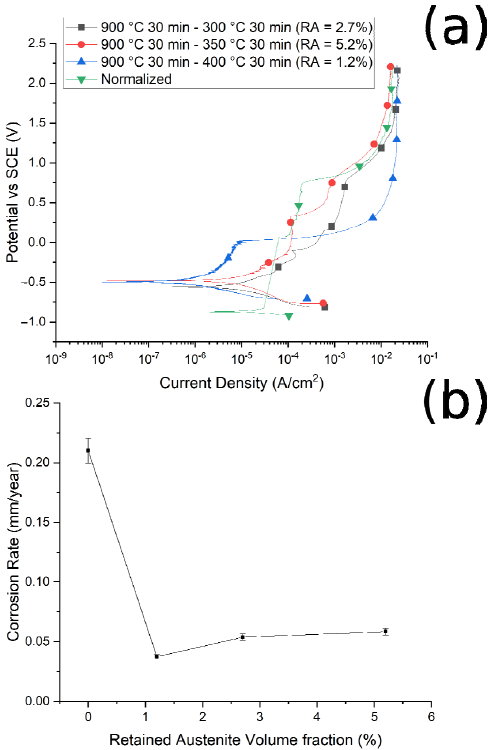
Figure 11. ( a ) Polarization curves of the samples austenitized at 900 ◦ C and austempered at 300 ◦ C, 350 ◦ C, and 400 ◦ C, and normalized at 900 ◦ C. ( b ) Relationship between corrosion rate and volume fraction of retained austenite. Test performed in borate buffer